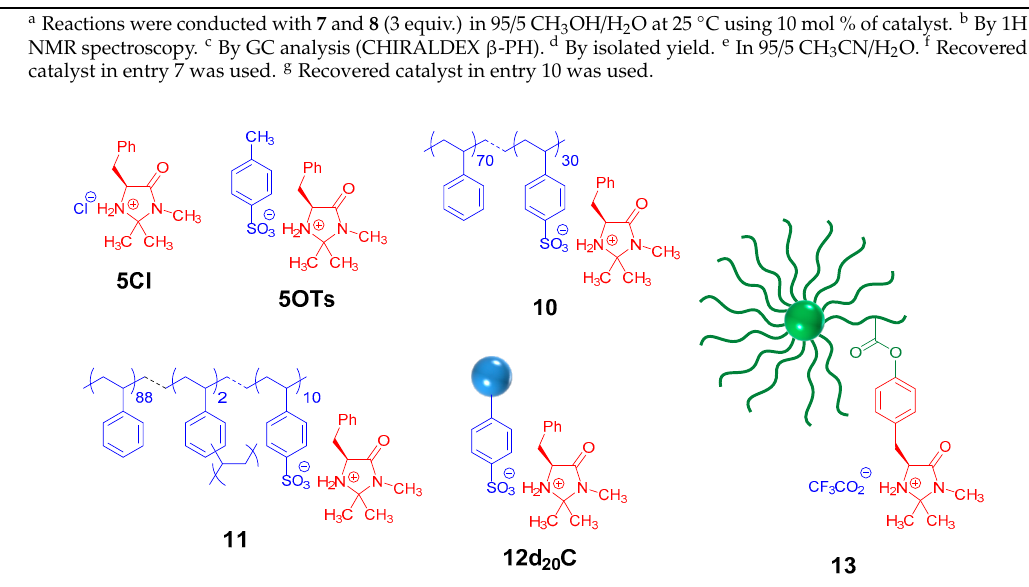
Figure 3. Model and polymeric MacMillan catalysts.